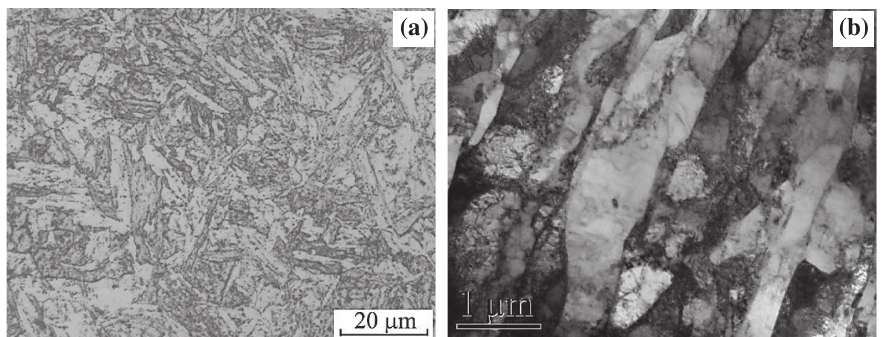
Figure 2: Microstructural morphol- ogy of 9 Cr modified steel (a) OP (2) TEM.